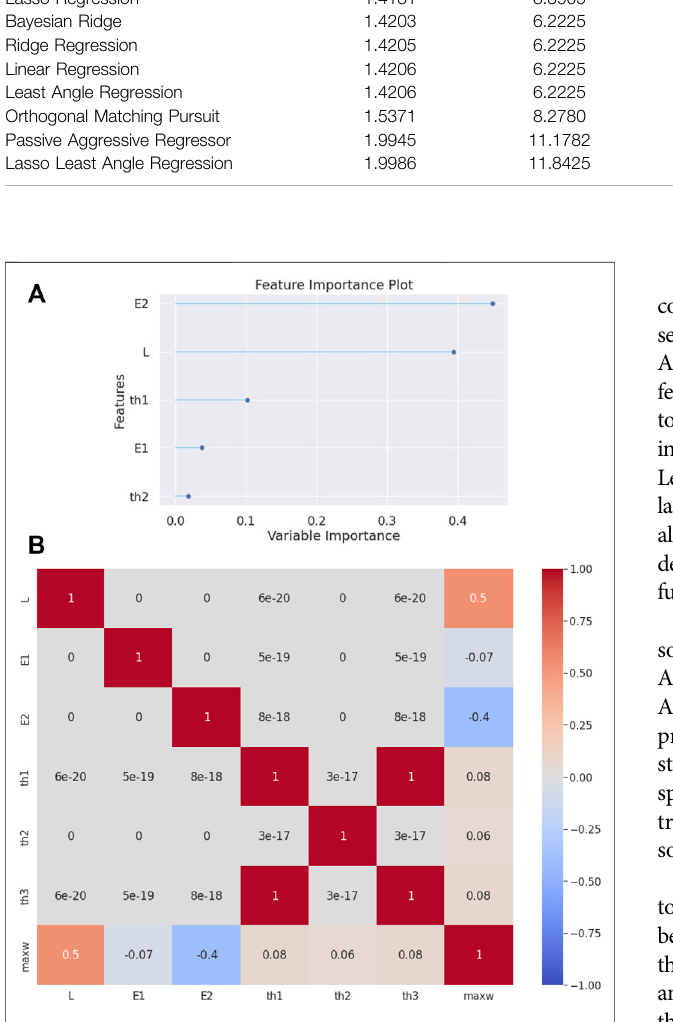
FIGURE 2 | (A) Feature importance plot and (B) correlation matrix heatmap for the clamped-clamped